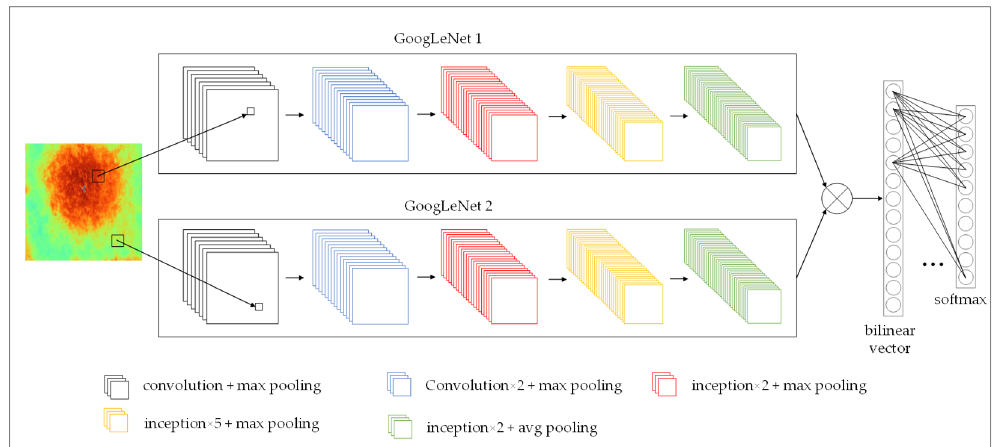
Figure 3. The architecture of the GLNB model.